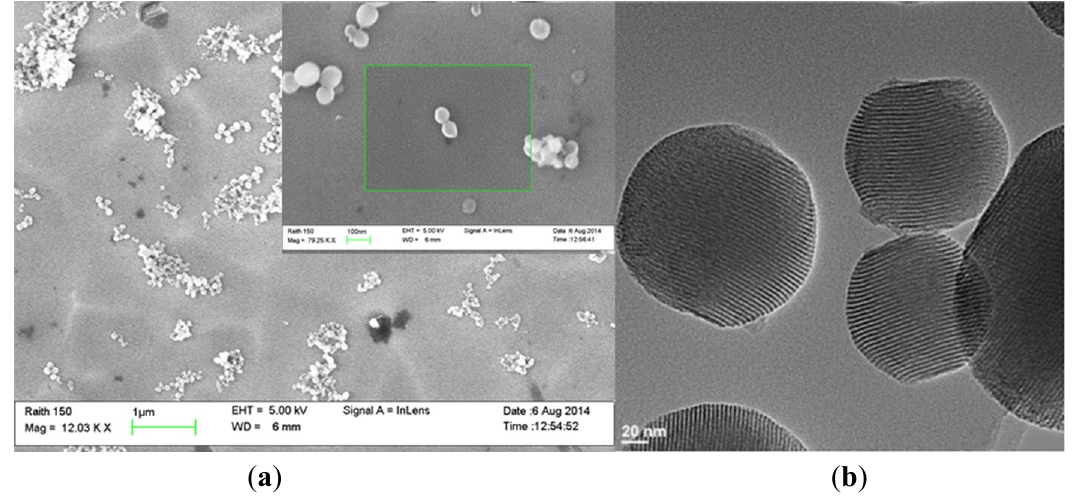
( a ) ( b ) Figure 2. ( a ) Scanning electron microscopy (SEM) micrograph of MSNs (Scale bar: 1 µm). Inset: close up of MSNs (scale bar: 100 nm). ( b ) Transmission electron microscopy (TEM) image of MSNs (scale bar: 20 nm). Table 1. Structural properties of MSNs, AlClPc-MSNs, cisplatin-MSNs, and AlClPc/cisplatin-MSNs.